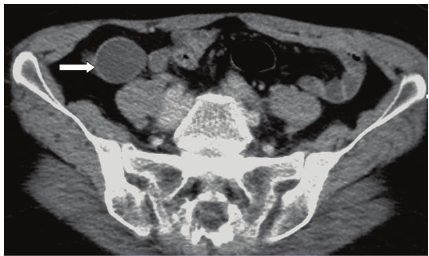
Figure 8: CT scan of the abdomen showing a mass in the right iliac fossa misdiagnosed as appendicular mass, white arrow (first